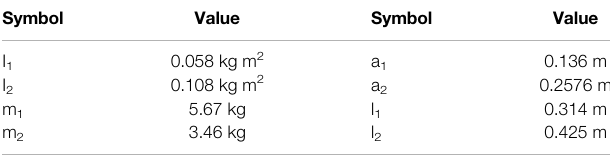
TABLE 1 | Physical parameter of a healthy human being (Seid et al., 2016). Symbol Value Symbol